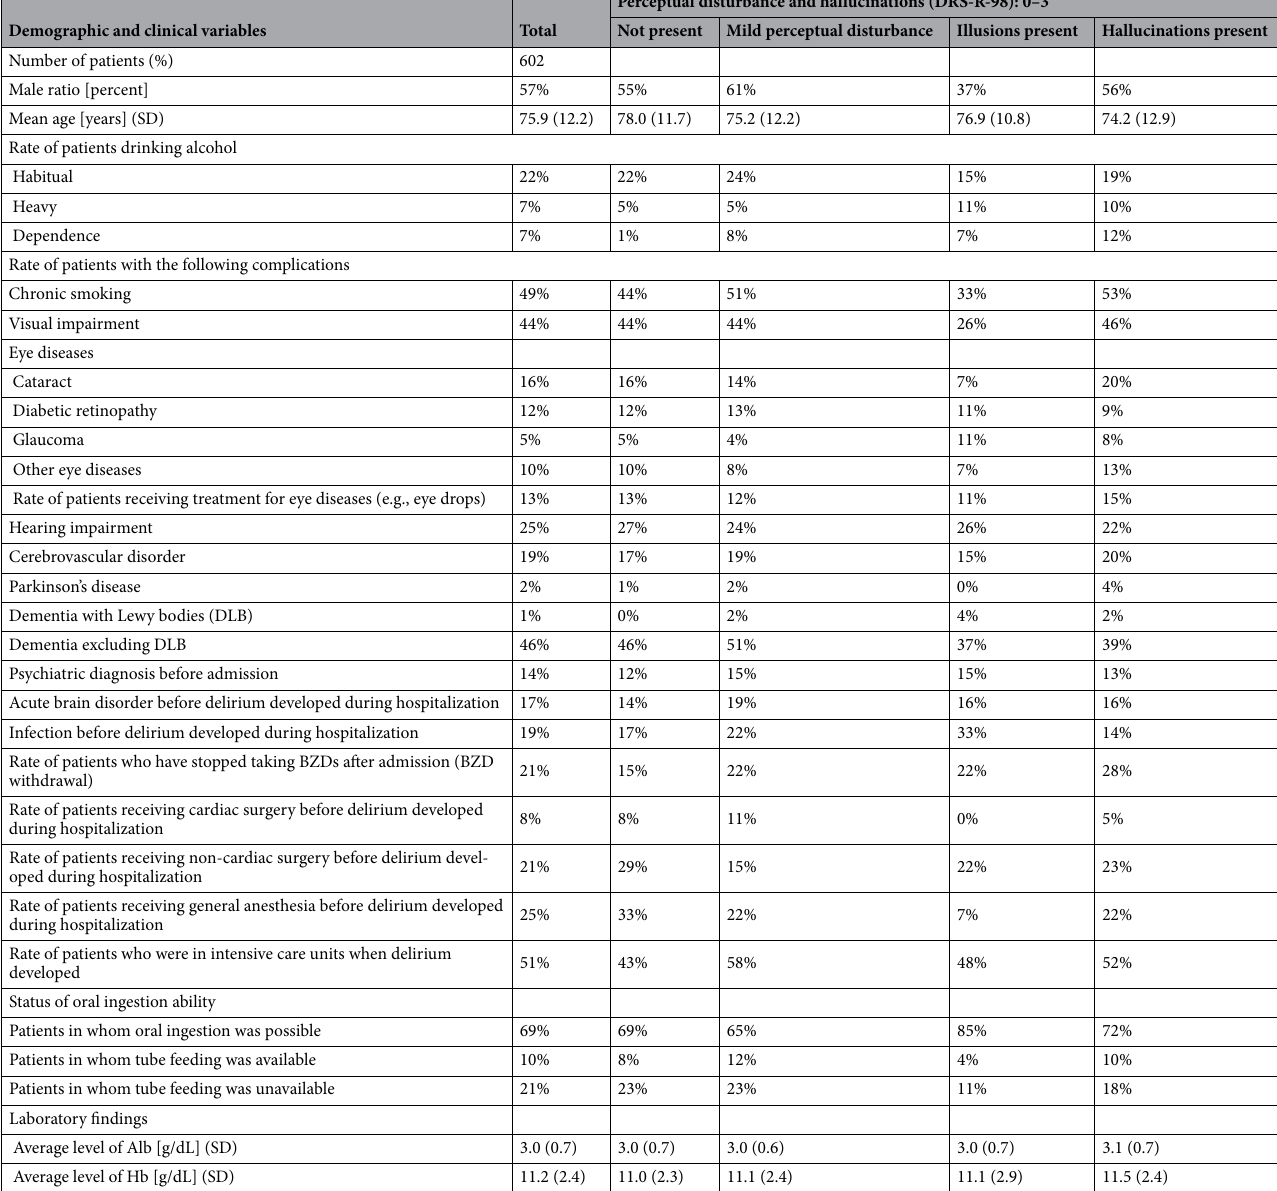
Table 1. Demographic and clinical characteristics of the patients with delirium. SD, standard deviation; BZD, benzodiazepine; Ab, albumin; Hb, hemogrobin; DLB, dementia with Lewy